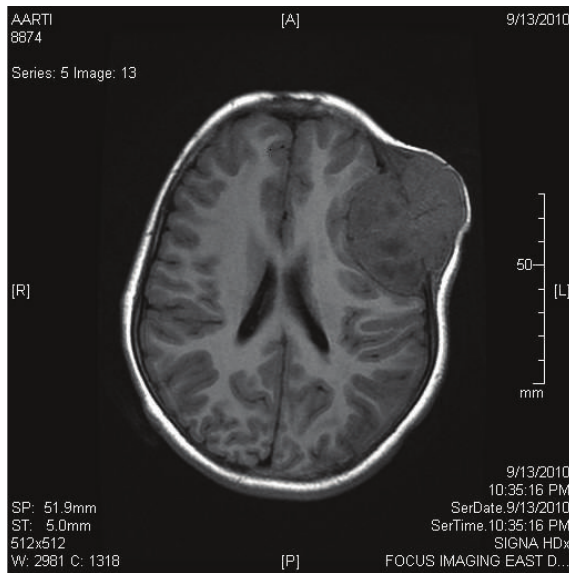
Figure 1: Postcontrast T1 weighted MRI showed intense, homoge- nously enhancing intracranial mass causing destruction of bone, with extradural soft tissue extension.